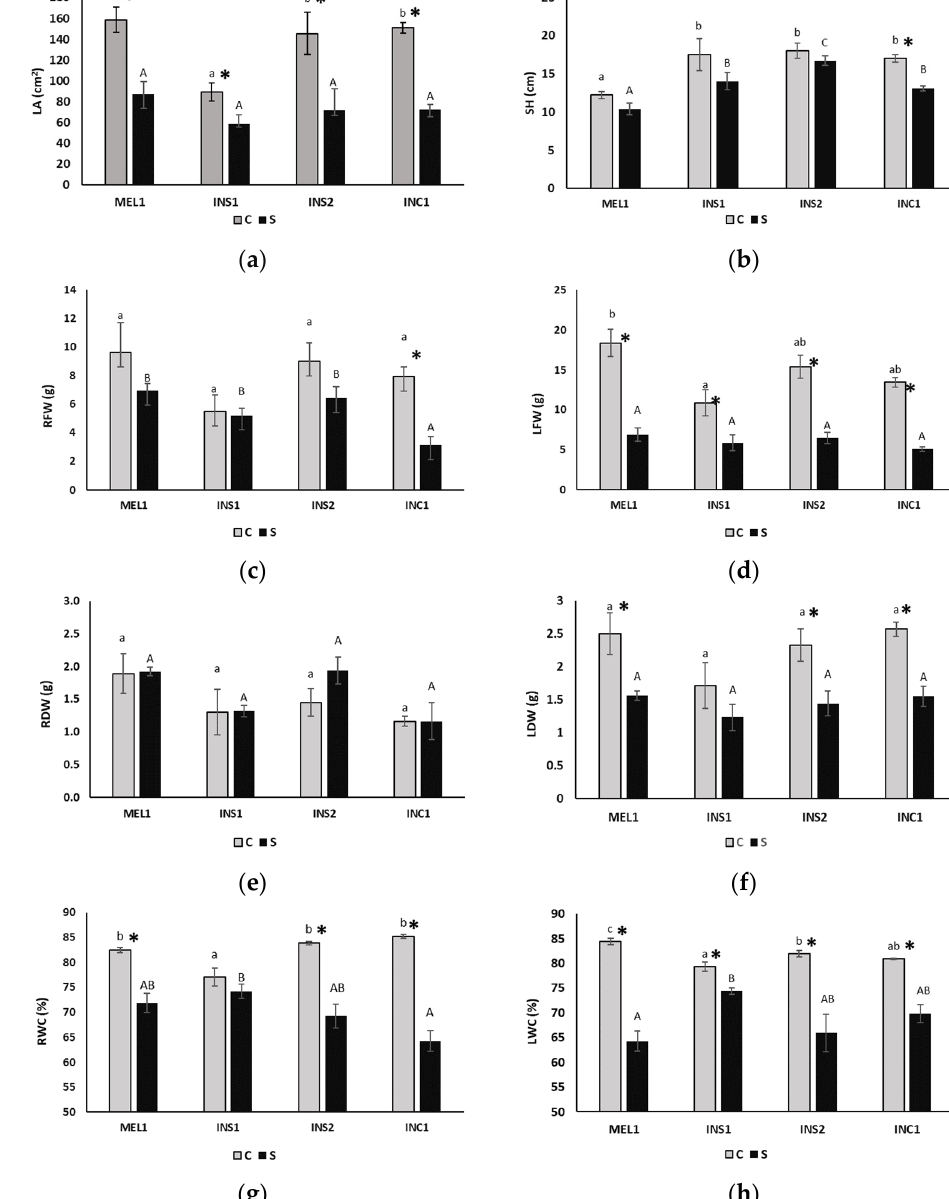
Figure 2. Variations in leaf area ( a ), stem height ( b ), root fresh weight ( c ), leaves fresh weight ( d ), root dry weight ( e ), leaves dry weight ( f ), root water content ( g ), leaves water content ( h ) between control and water-stressed plants of the indicated genotypes, after 18 days of treatment. Accessions are defined in Table 1. Bars represent means ( n = 5) with standard errors. Different letters (lowercase for control plants and uppercase for water-stressed plants) indicate significant differences between genotypes according to the multiple range test with the Student-Newman-Keuls method at a p -value < 0.05. The asterisk indicates significant differences between the control and drought treatments, for each genotype, according to the p-value of the ANOVA F-test.